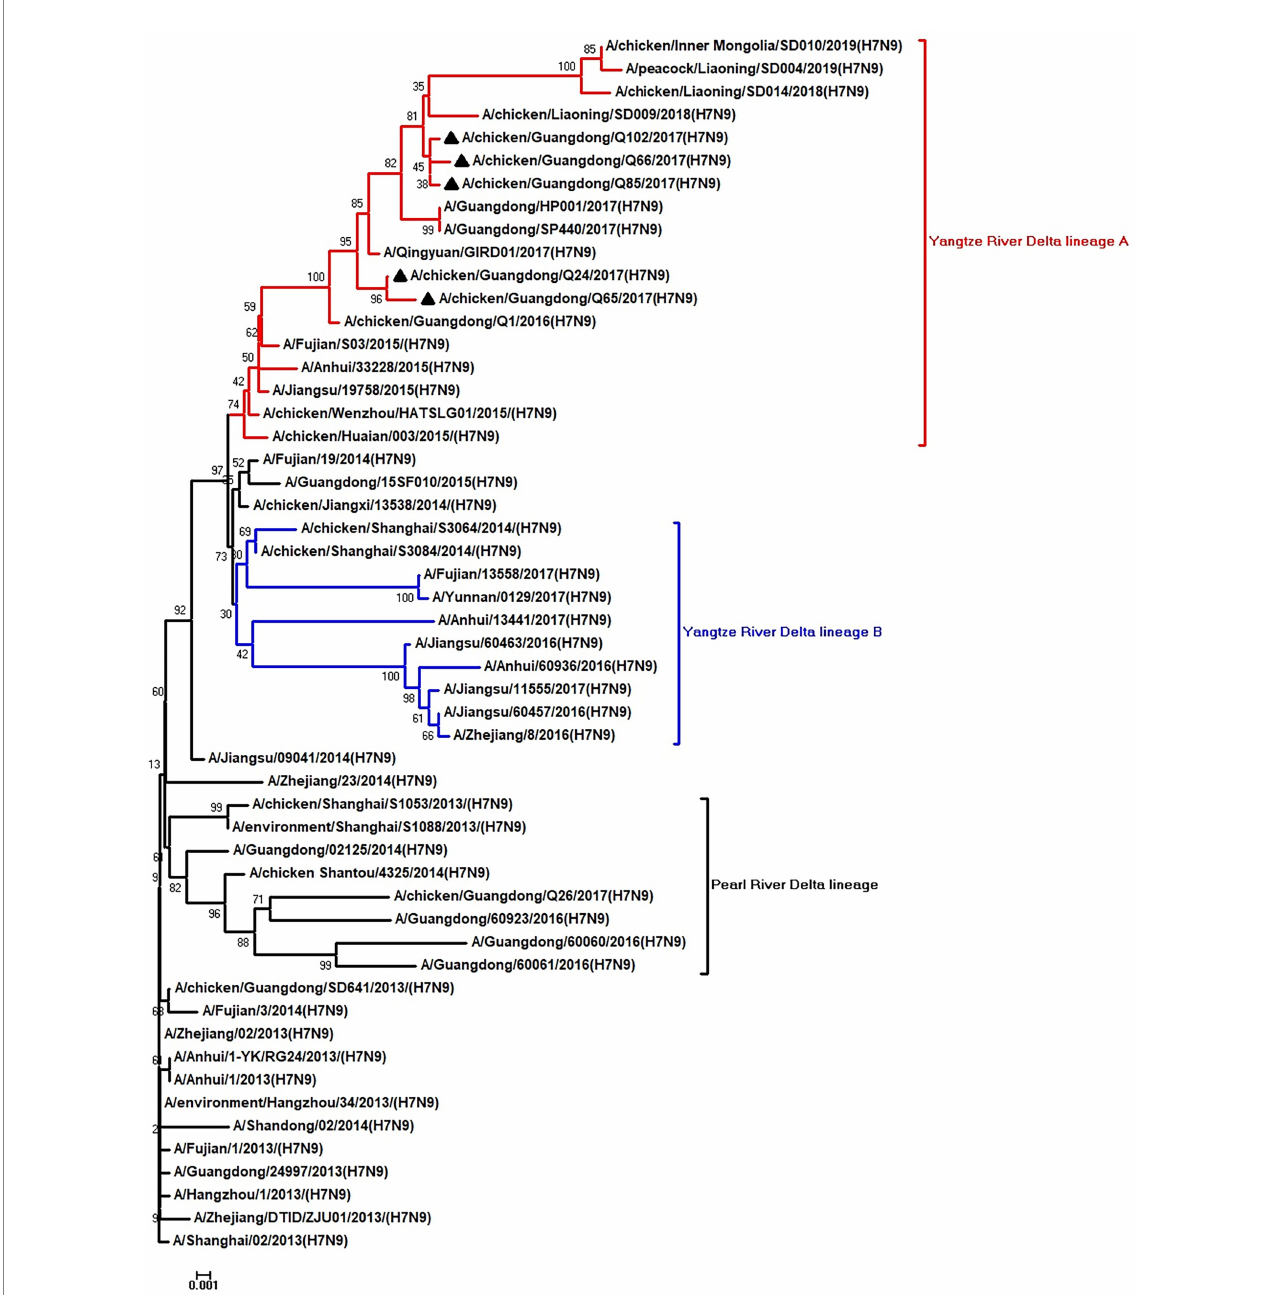
FIGURE 2 Phylogenetic analysis of NA. The tree was constructed by using the neighbor joining method with the Maximum Composite Likelihood model and MEGA version 5.2 (www.megasoftware.net/) with 1,000 bootstrap replicates based on the following sequences: NA: nt 19–1,416. Except our five isolates, other virus sequences were downloaded from GenBank. Triangles indicate the viruses characterized in this study. The scale bar indicates the branch length and corresponds to 0.001 estimated amino acid substitutions per